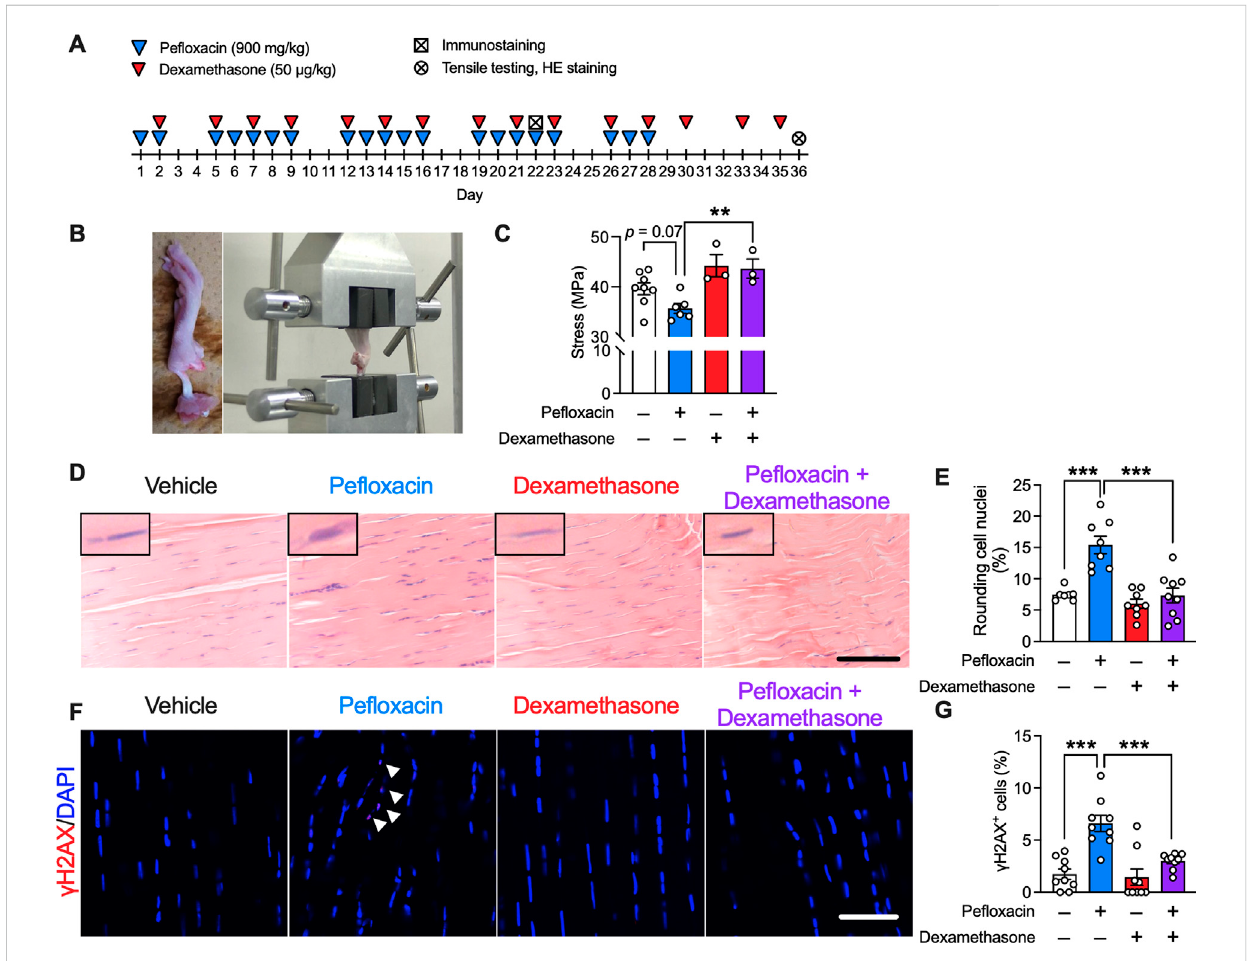
FIGURE 4 Effects of dexamethasone on a pe fl oxacin-induced tendinopathy rat model. (A) Rats were treated with pe fl oxacin (900 mg/kg/day, 5 days a week for4 weeks),dexamethasone(50 µg/kg/day,3 daysaweekfor5 weeks),orboth,andAchillestendonswerecollected1 dayaftercompletingthe3-week administration for immunostaining and 1 day after completing the 5-week administration for tensile testing and hematoxylin and eosin staining (HE staining). (B) Images of biomechanical testing. (C) Biomechanical properties were examined immediately after the collection of Achilles tendons from drug-administered rats ( n = 3 – 8 per group). Maximum stress was calculated from test results. (D,E) Representative images of HE staining ( n = 7 – 9 per group) with representative nuclei in the upper left of each picture; summarized data for cells with round nuclei. Scale bar: 0.1 mm. (F,G) Immunostaining of γ H2AX was performed, and the samples were imaged using confocal microscopy ( n = 9 per group). The number of γ H2AX + cells (shown with the arrowhead) is presented as a percentage of the number of total cells. Scale bar: 50 µm. Data are shown as mean ± SEM. Statistical signi fi cance was tested using a two-way ANOVA with post hoc multiple comparisons; ** p < 0.01, *** p <